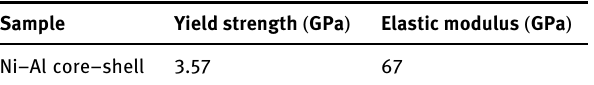
Table 1: Yield strength and elastic modulus of the sample obtained in the present work